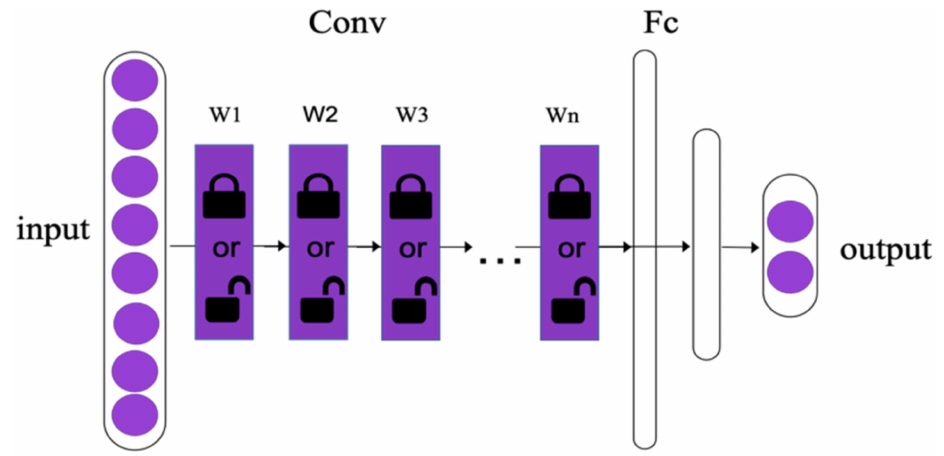
Figure 4. Shallow and deep fine-tuning.